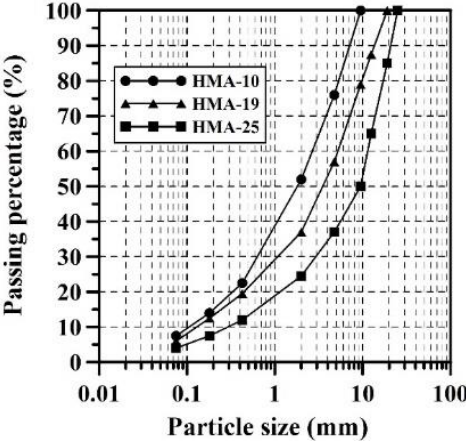
Figure 2. Particle size distribution curves (gradations) of HMAs.